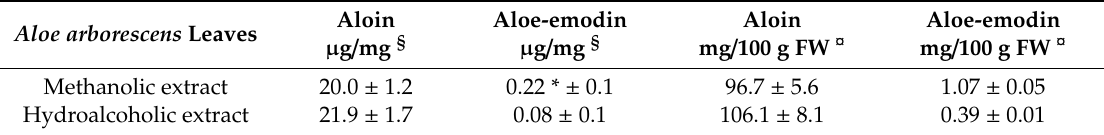
Table 1. Aloin and aloe-emodin contents in A. arborescens leaf extracts. Aloe arborescens Leaves